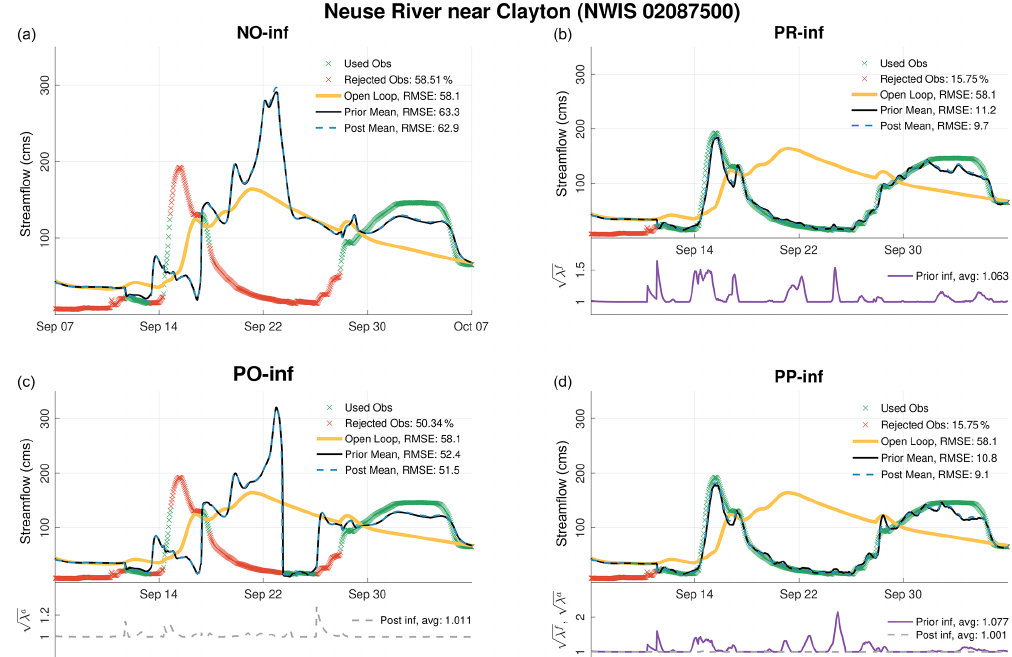
Figure 7. Time series of prior and posterior ensemble means, at the upstream Neuse River near Clayton gauge, resulting from the following four different DA runs: no inflation (a) , prior inflation (b) , posterior inflation (c) , and prior and posterior inflation combined (d) . The open- loop hydrograph (in cms) is also shown. Assimilated and rejected observations are shown with green and red crosses, respectively. The inflation mean time series is plotted according the right y axes. Time-averaged RMSE for each hydrograph is reported in the legend. The √ √ λ f , and posterior, λ a , inflation are also given in the legend. average values of prior,